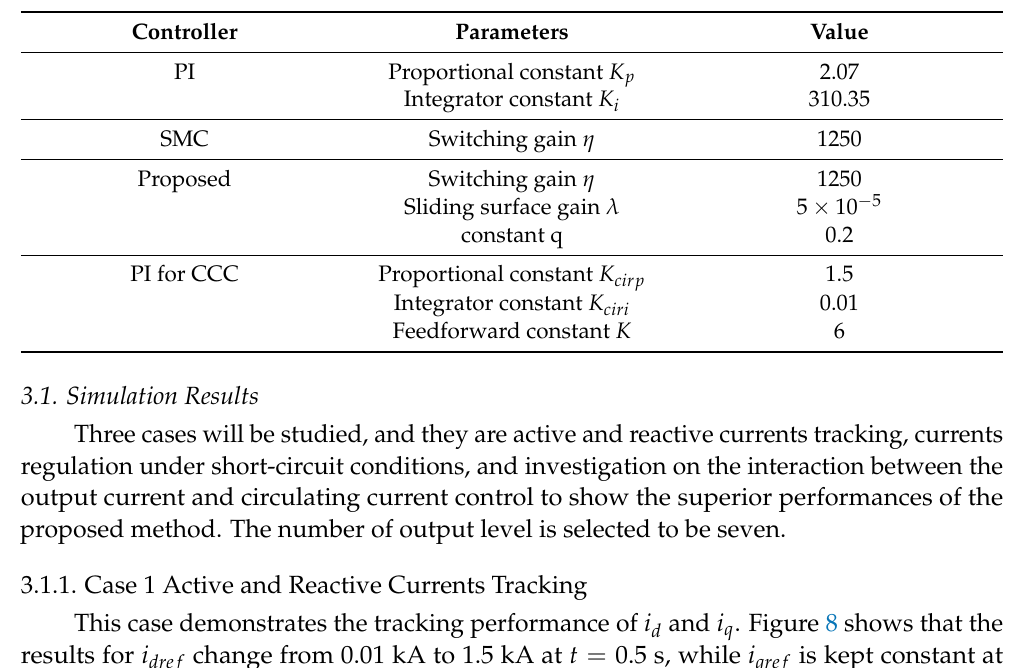
Table 2. Controller parameters.